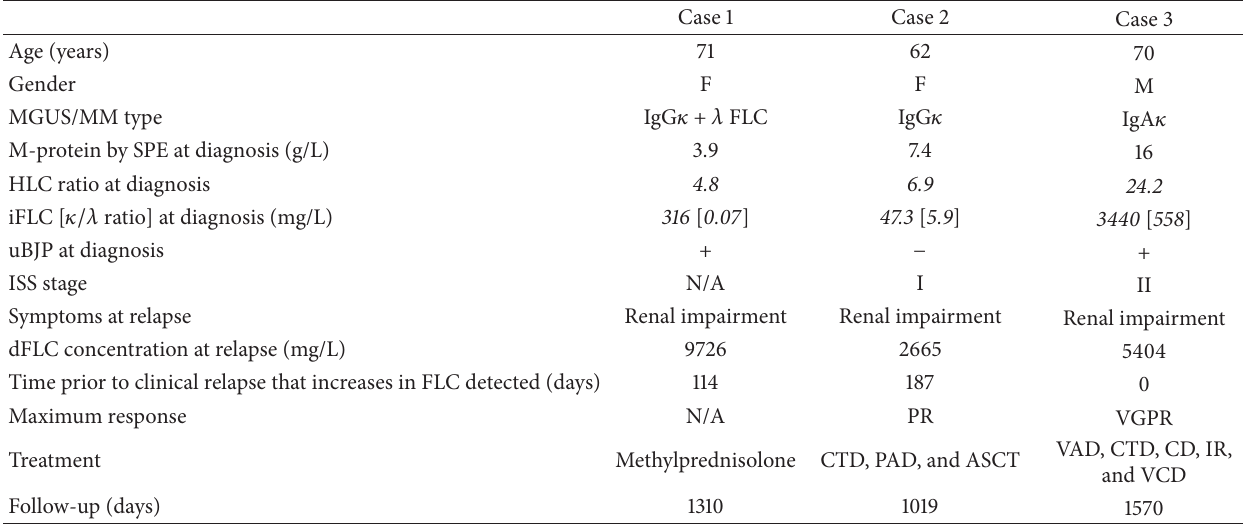
Table 1: Patient characteristics for three cases of progression to LCMM by light chain